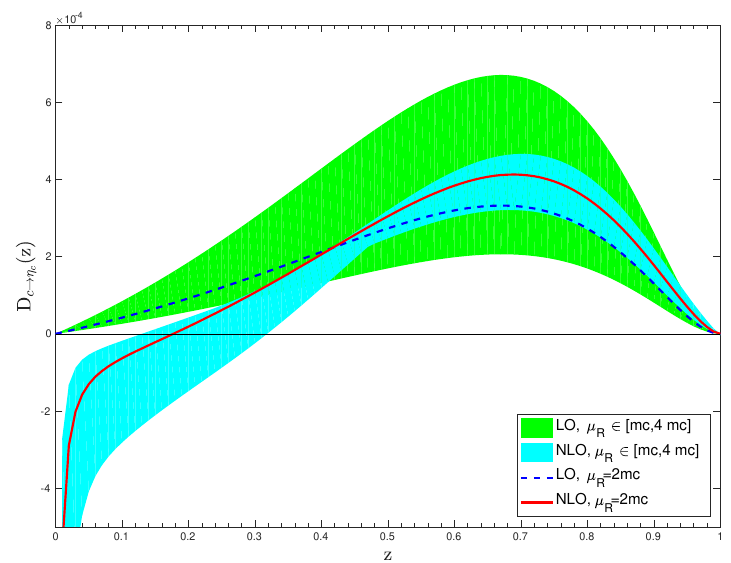
Figure 4 . The fragmentation function D c → η where µ F = 3 m c and µ R = 2 m c . The bands are obtained by varying the renormalization scale µ R by a factor of